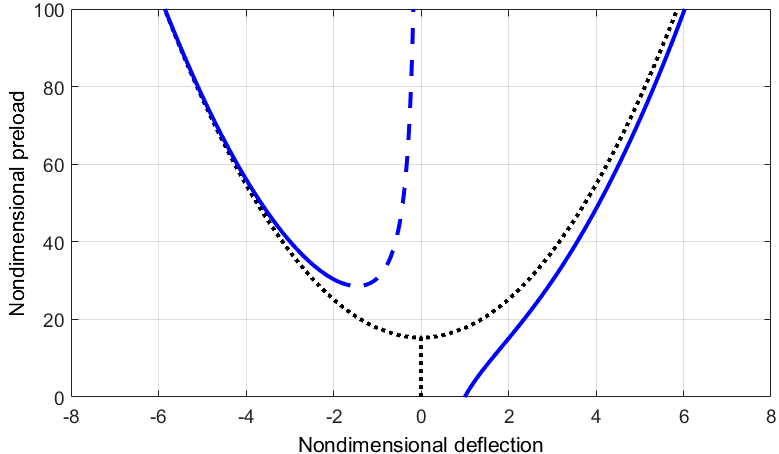
Figure 6. Variation of the static deflection with the pre-load at 𝑎 = 1,𝜇̅ = 0.04 and 𝛼 = 1 .